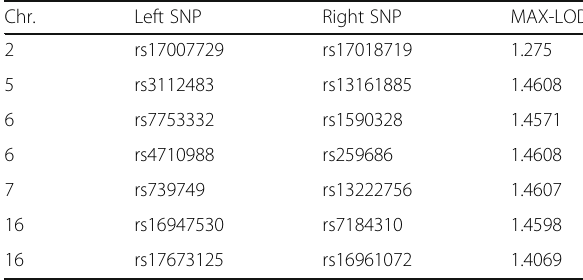
Table 2 List of linkage regions with MAX-LOD scores above 1.0